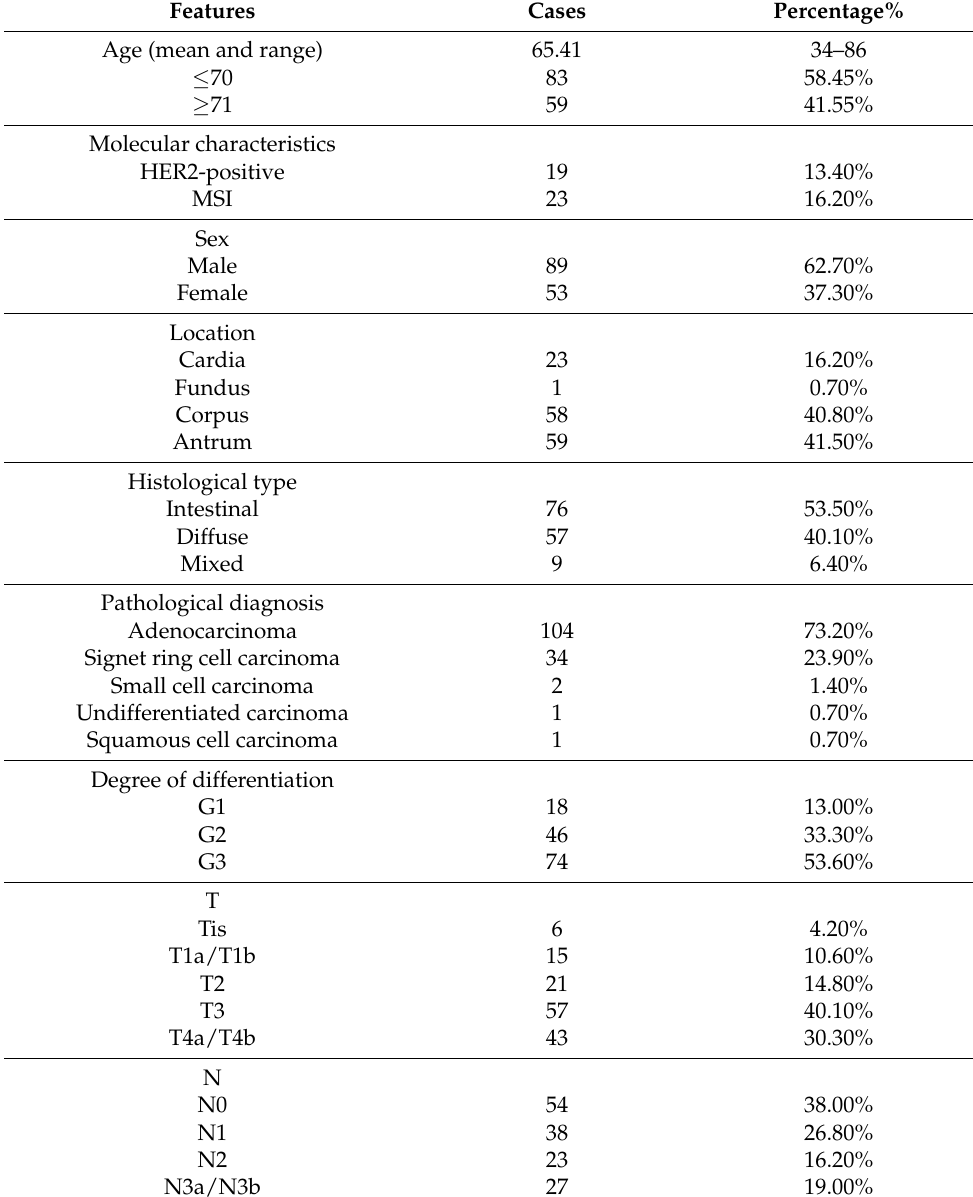
Table 1. Clinical, pathological and molecular (HER2 positivity and MSI) features of the 142 patients with gastric